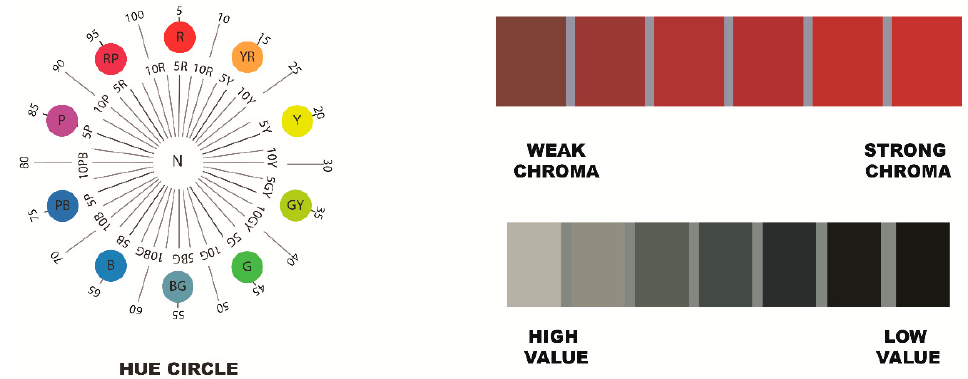
Figure 1. Three dimensions of color (adapted and re-drawn from ©1994 Encyclopedia Britannica, Inc., Chicago, IL, USA).